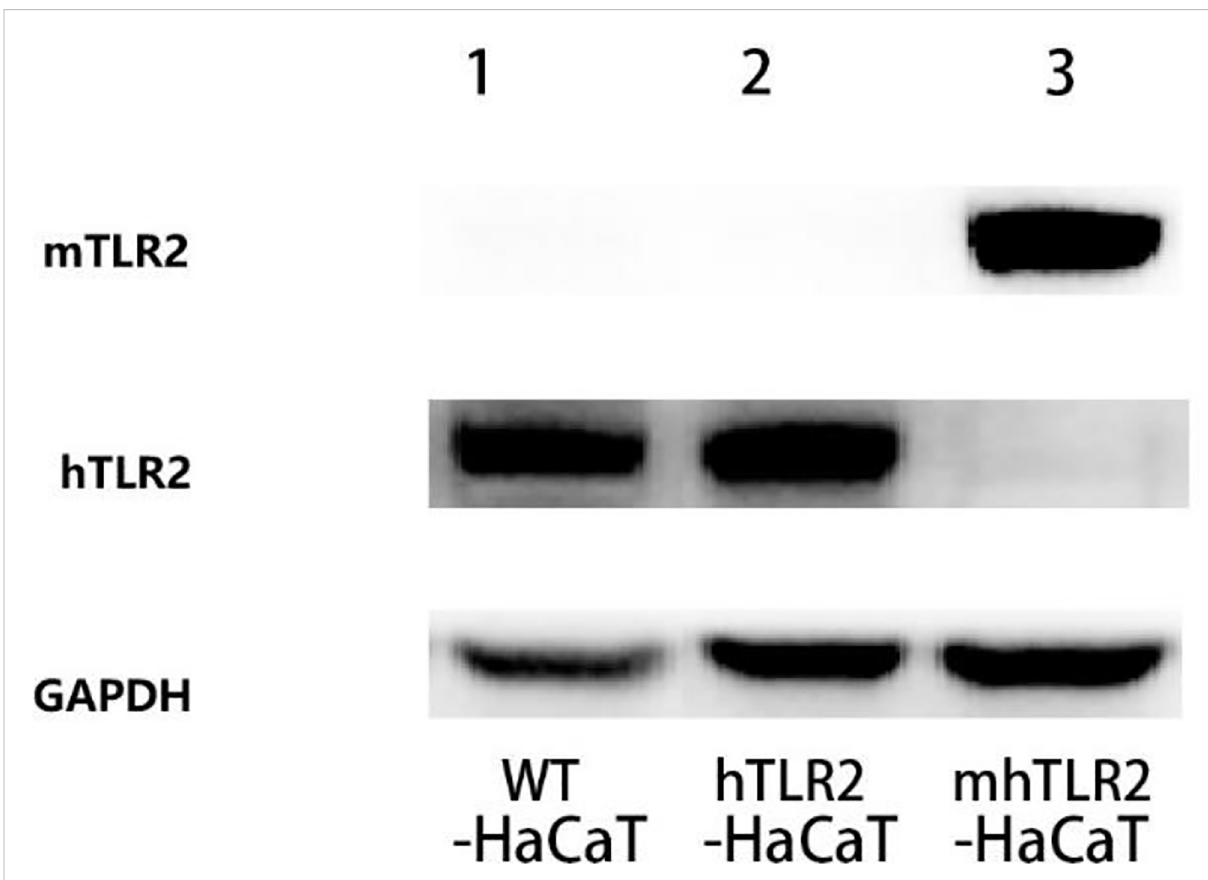
FIGURE 2 The immunoblotting results of TLR2 protein. Line 1 for WT-HaCaT cells, line 2 for hTLR2-HaCaT cells, and line 3 for mhTLR2-HaCaT cells. Representative data are presented from one of the three independent experiments. (mTLR2 represents mouse TLR2; hTLR2 represents human